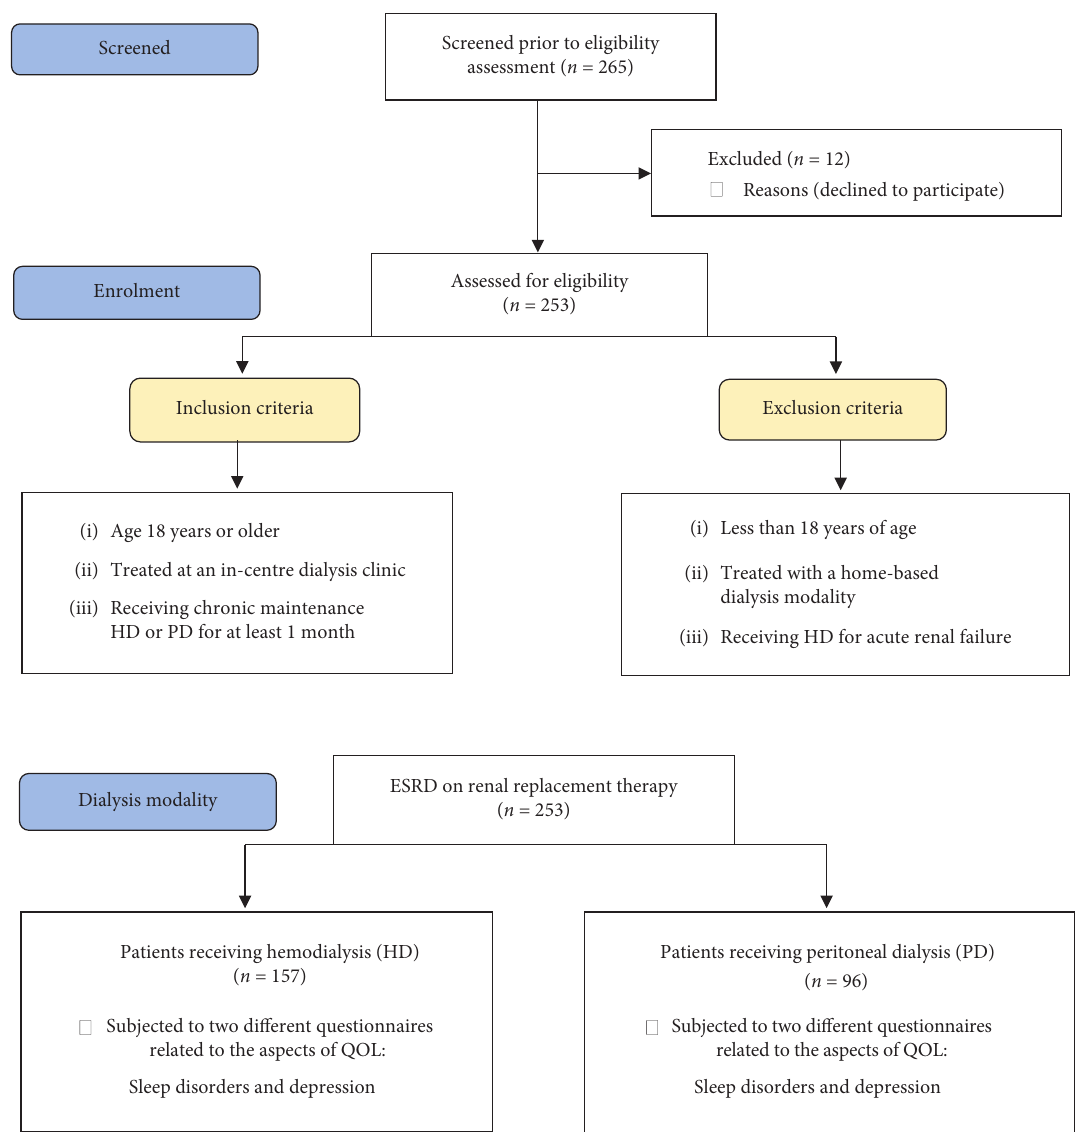
Figure 1: Study flow